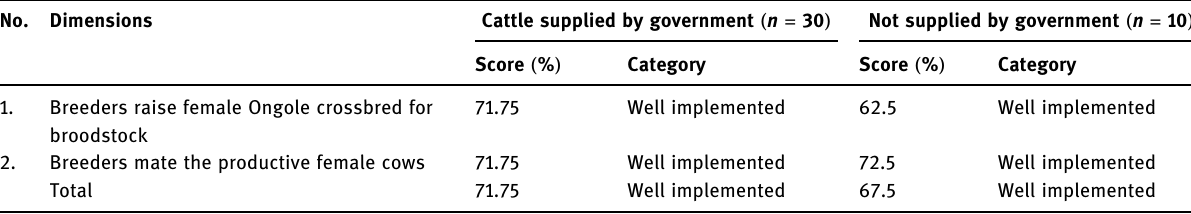
Table 5: Breeders ’ behavior in conserving productive female cows No.